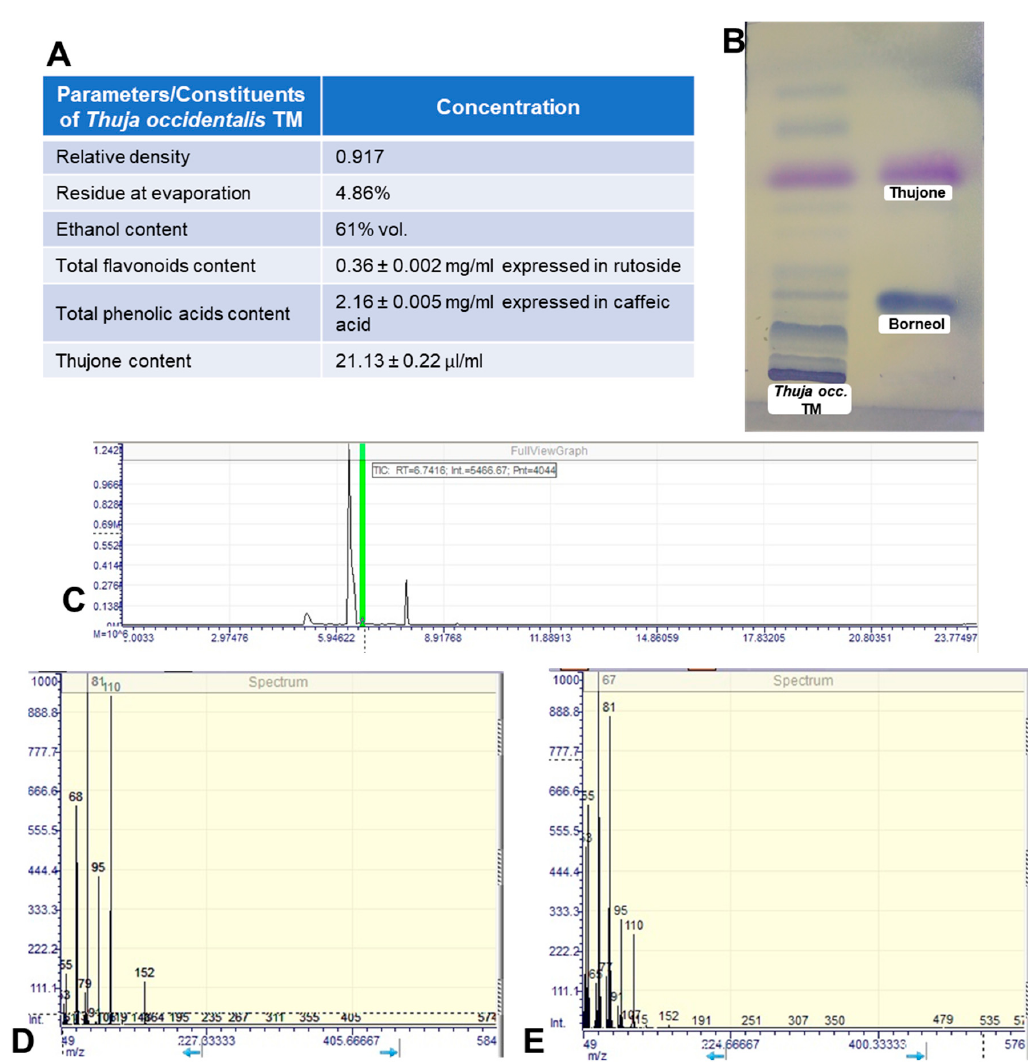
Figure 1. Characterization of the obtained Thuja occidentalis mother tincture (MT). ( A ) The main characteristics of Thuja occidentalis MT. ( B ) Thin layer chromatography (TLC) of Thuja occidentalis MT (left column) and standards (right column). ( C ) Gas chromatography (GC) chromatogram of Thuja occidentalis MT (green mark for thujone). ( D ) Mass spectrometry (MS) spectra of thujone from Thuja occidentalis MT. ( E ) MS spectra of standard thujone.